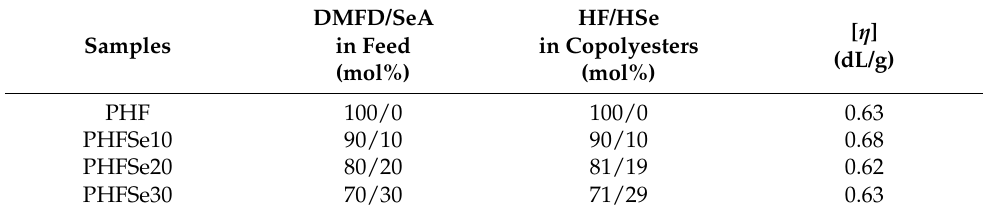
Figure 1. Chemical structure and 1 H NMR spectra of PHF and PHFSe copolyesters. Table 1. Compositions and [ η ] of PHF and PHFSe copolyesters.